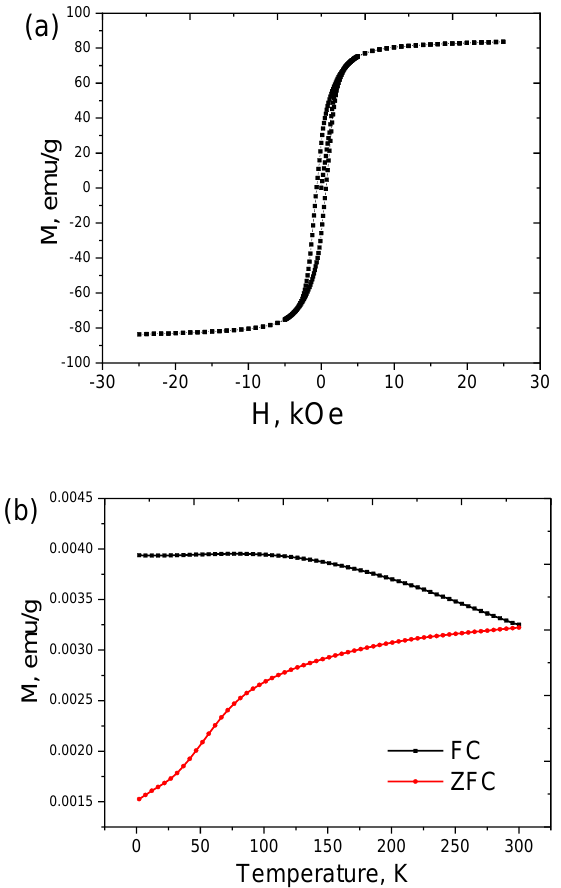
Figure 3. ( a ) Magnetization curve of Fe@C nanoparticles at room temperature; ( b ) zero-field-cooled (ZFC) and field-cooled (FC) magnetization curves measured under an applied magnetic field of 100 Oe.